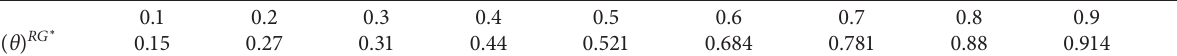
Table 1: The corresponding value of subsidy parameters under the same government subsidy expenditure.